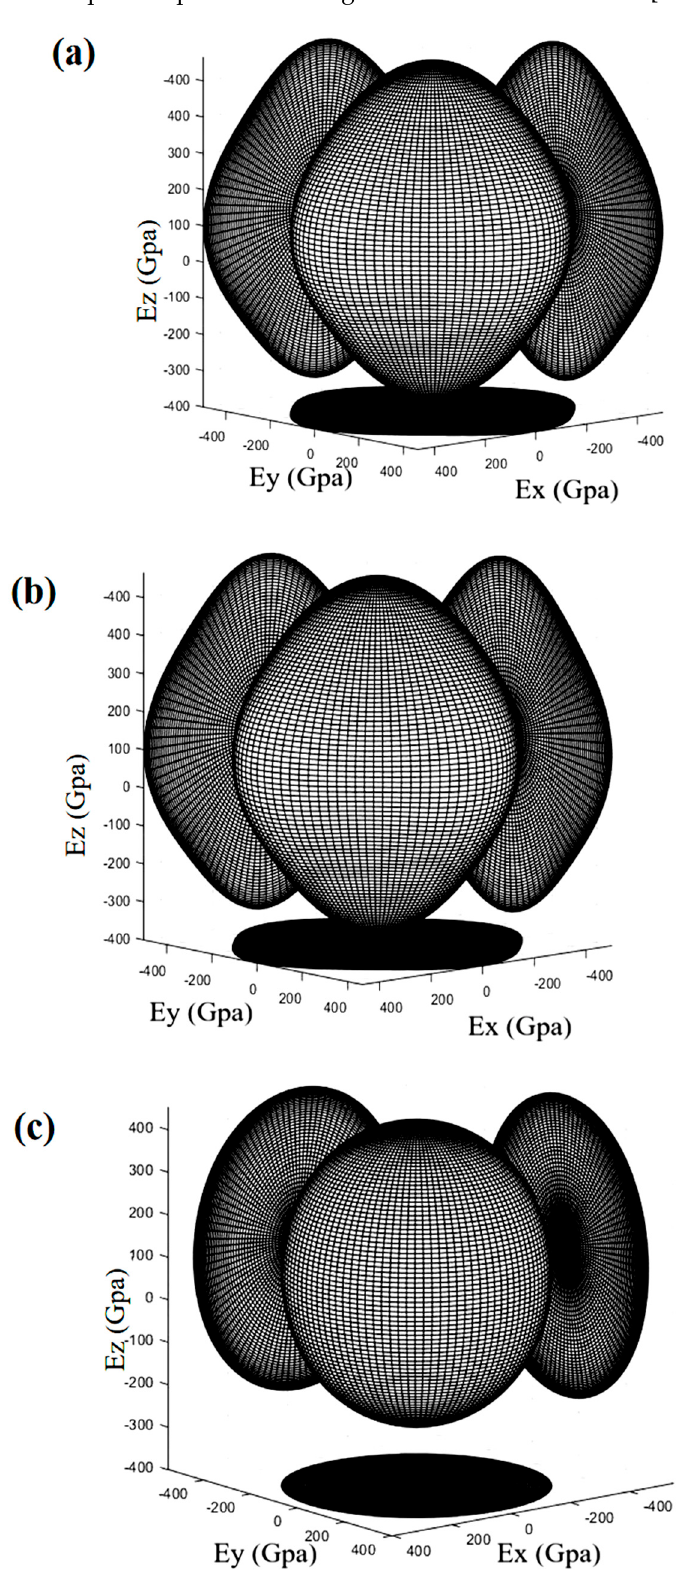
Figure 8. Typical 3D Young's modulus diagram of ( a ) Ti 32 N 32 ; ( b ) Ti 30 Cu 2 N 32 ; and ( c ) Ti 24 Cu 8 N 32 .